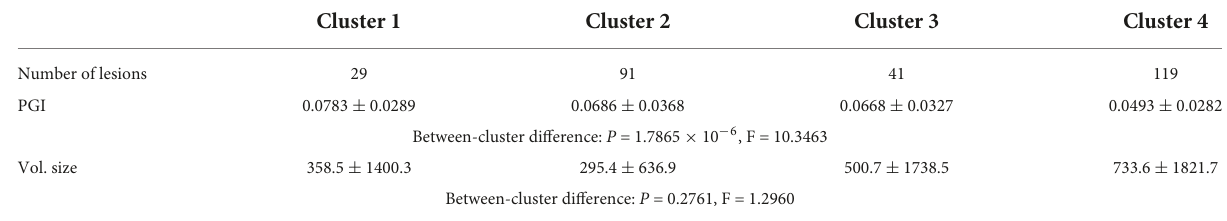
TABLE 3 ANOVA analysis of the potential growth indices (PGIs) for texture clusters and corresponding lesion sizes for all 280 lesions. Texture